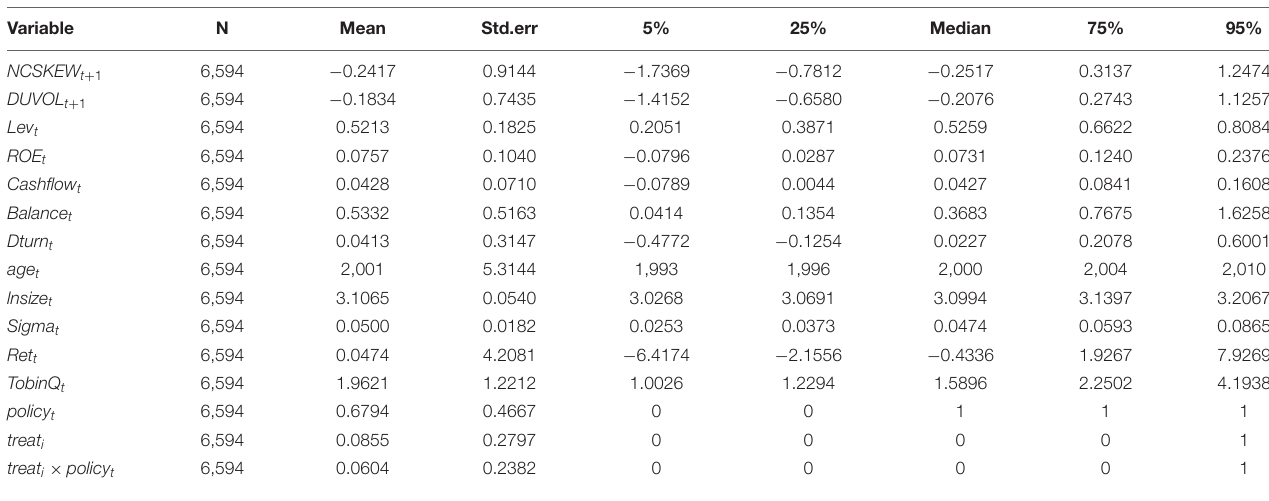
TABLE 1 | Summary